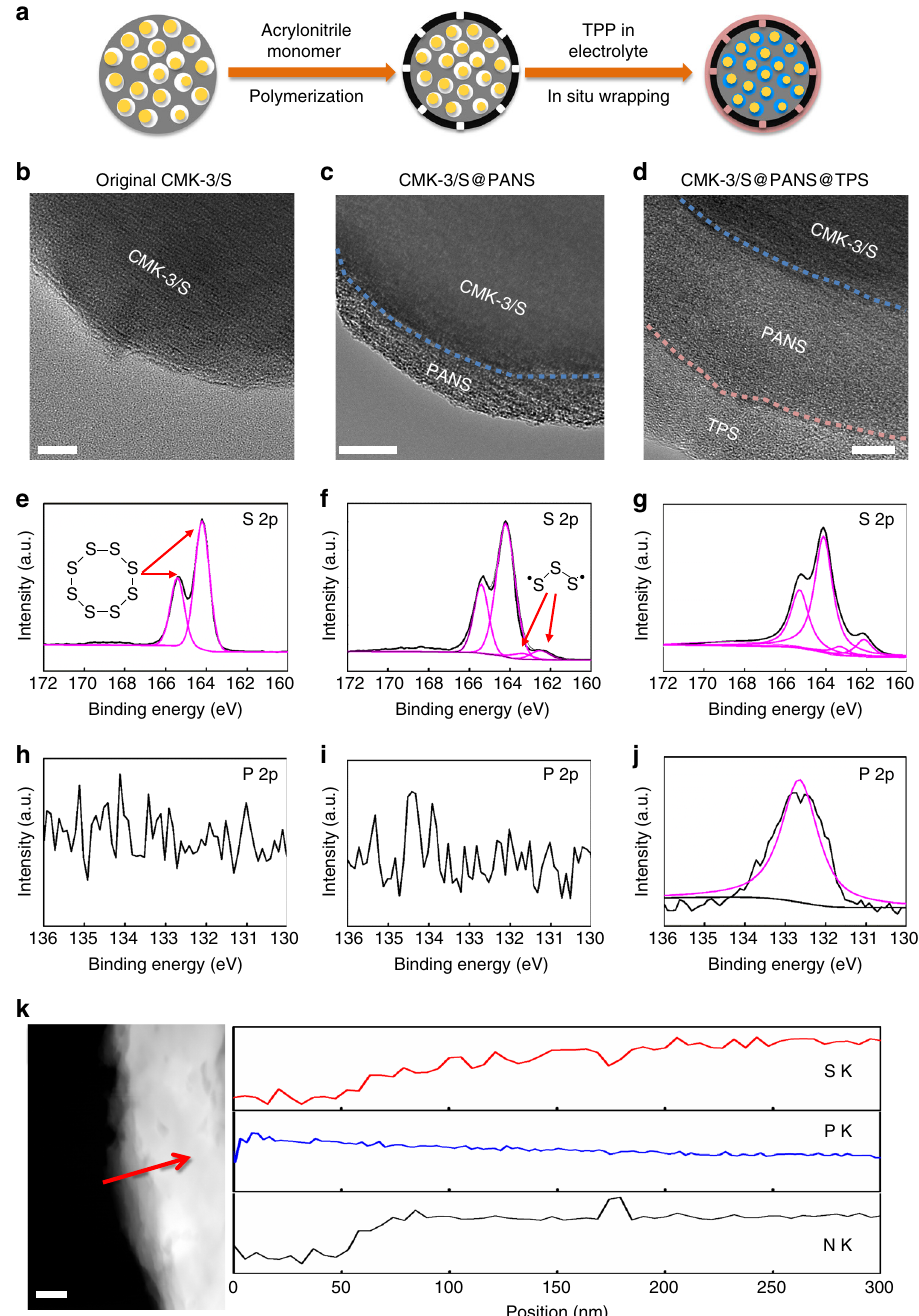
Fig. 2 Materials characterization. a Schematic illustration of the in situ wrapping process. TEM images of b CMK-3/S, scale bar : 20 nm, c CMK-3/S@PANS, scale bar : 50 nm and d CMK-3/S@PANS@TPS particles, scale bar : 10 nm. S 2p XPS spectra of e CMK-3/S, ( f ) CMK-3/S@PANS, and g CMK-3/S@PANS@TPS samples. P 2p XPS spectra of h CMK-3/S, i CMK-3/S@PANS, and j CMK-3/S@PANS@TPS samples. k TEM image of a CMK-3/ S@PANS@TPS particle and the EDX elemental mapping across the multi-layered core – shell composite particle along the dashed line with the arrow